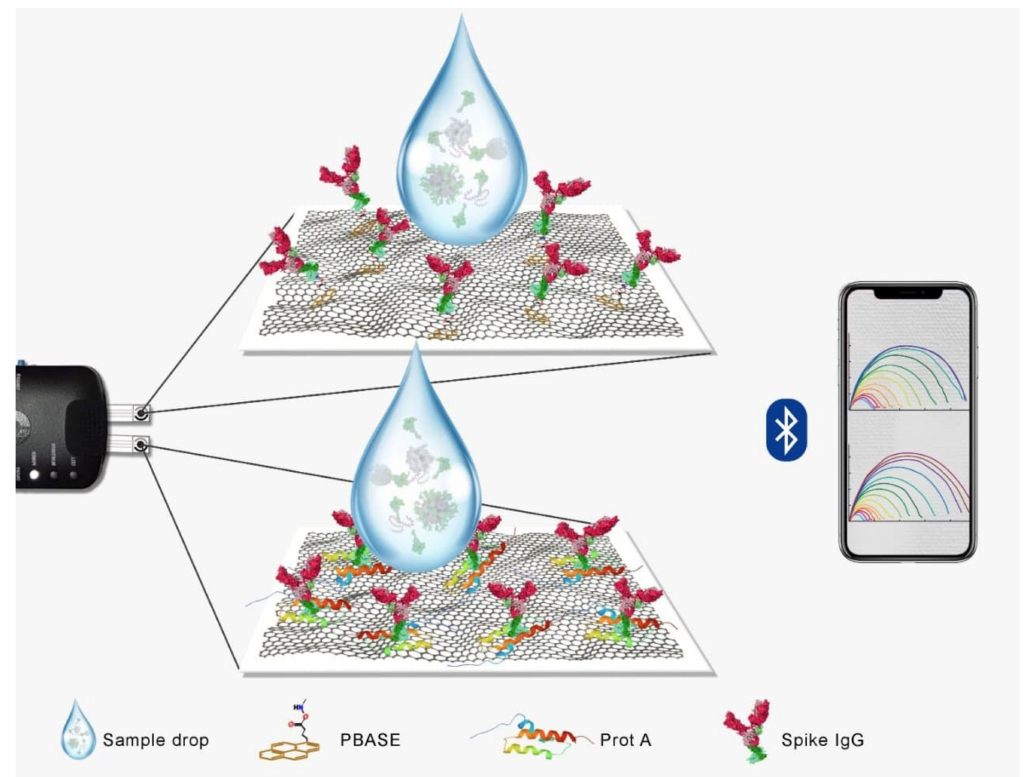
Figure 2. A schematic illustration of the strategies adopted in this work for immunosensing of the coronavirus in the nasopharyngeal samples using paper substrates, and graphene electrode. The difference between the two strategies is also shown where the immobilization in the top of the frame is PBASE mediated one and the immobilization in the bottom frame is protein mediated one. The sensor signals were transmitted to a mobile device using